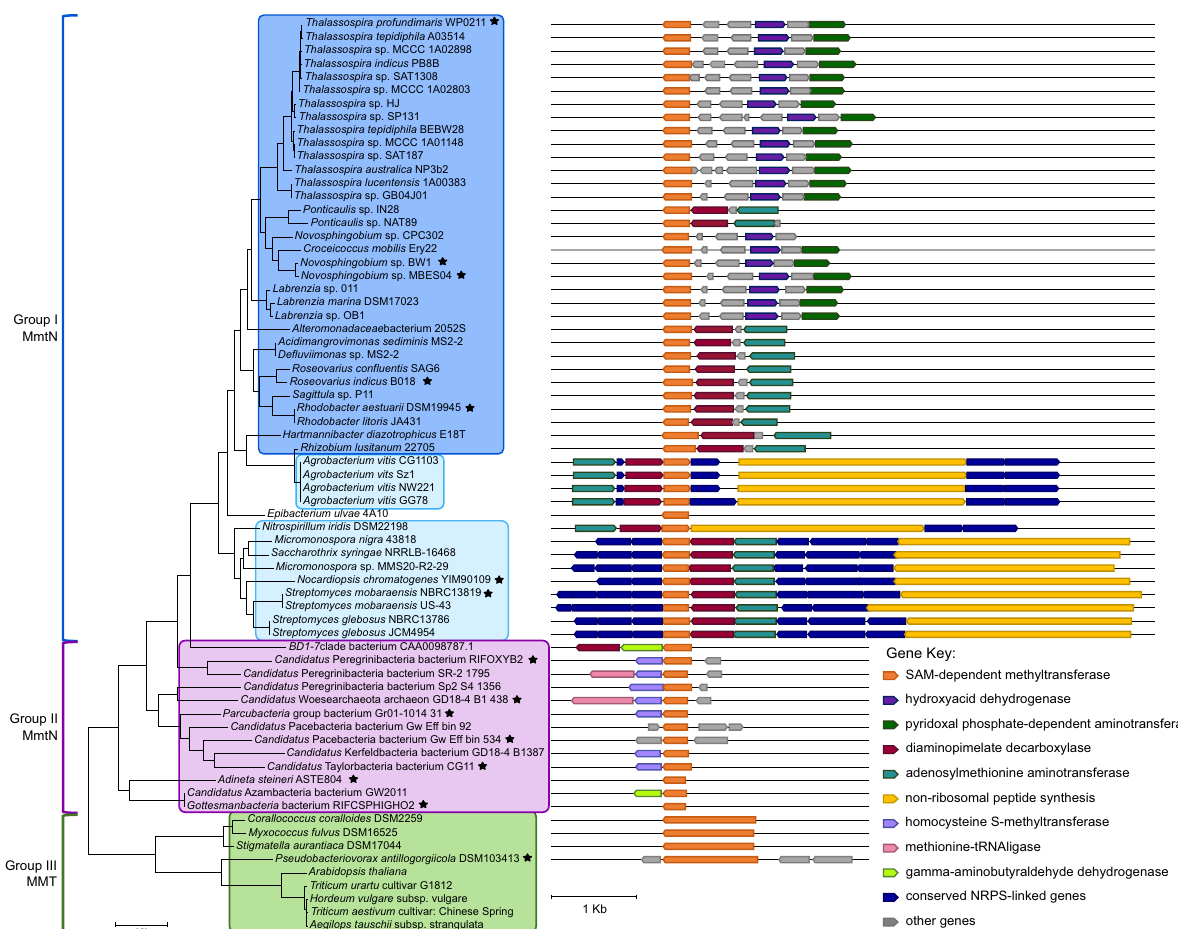
Fig. 7 The diversity of functional MmtN family Met S -methyltransferases. Maximum-likelihood phylogenetic tree of MmtN family Met S - methyltransferases, indicating their proposed separation into three groups (I, II and III). The gene neighborhood of each mmtN or MMT gene is indicated. The two subgroups of the bacterial Group I MmtN proteins are indicated by light and dark blue boxes, de fi ned by the presence or absence of the non- ribosomal peptide synthesis gene (yellow) linked to mmtN , respectively. The Group II MmtN from CPR bacteria, DPANN archaea and the animalcule Adineta steineri are indicated by purple boxes, and plants and bacteria containing Group III MMT are boxed in green. The phylogenetic tree is based on 65 protein sequences. Species with MmtN/MMT enzymes that have been demonstrated to be functional methionine S -methyltransferases are indicated by a black star. The relevant genes in the neighborhood map are indicated as arrows and are to scale. mmtN / MMT (SAM-dependent methyltransferase) genes are orange, and a color-coded key indicates the products of genes associated with it that are predicted to be involved in DMSP synthesis and/or other secondary metabolites in the respective bacteria, or in SMM cycling in Group II species. Grey arrows indicate genes that are not currently known/predicted to be involved in